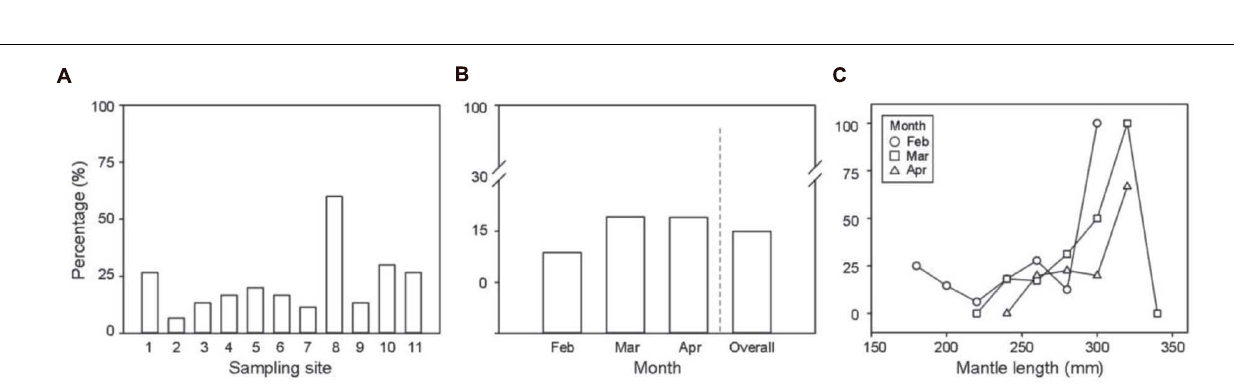
FIGURE 6 | Risks of artifact ingestion for the Argentine shortfin squid Illex argentinus in the Southwest Atlantic. Percentage distributions of artifact ingestion by (A) sampling site, (B) month, and (C) mantle length. Squid sizes, ranging between 150 and 350 mm mantle length, are grouped into 20 mm intervals.